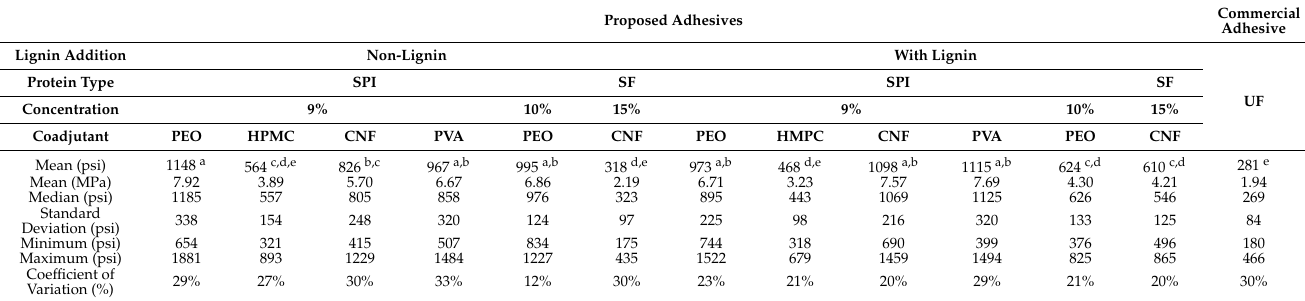
Table 2. Analyzed data of strength at break point of white maple according to the type of tested adhesive.